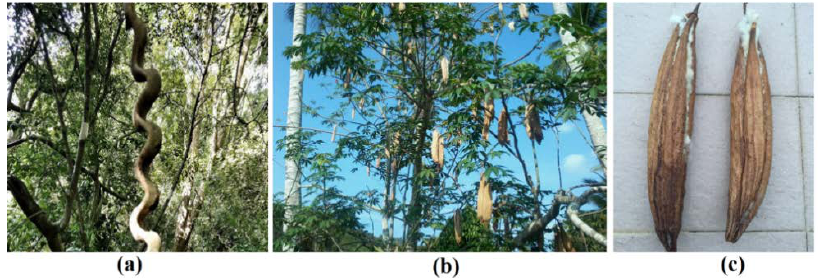
Figure 1. ( a ) E. spiralis plant, ( b ) C. pentandra plant and ( c ) C. pentandra fiber in the seed